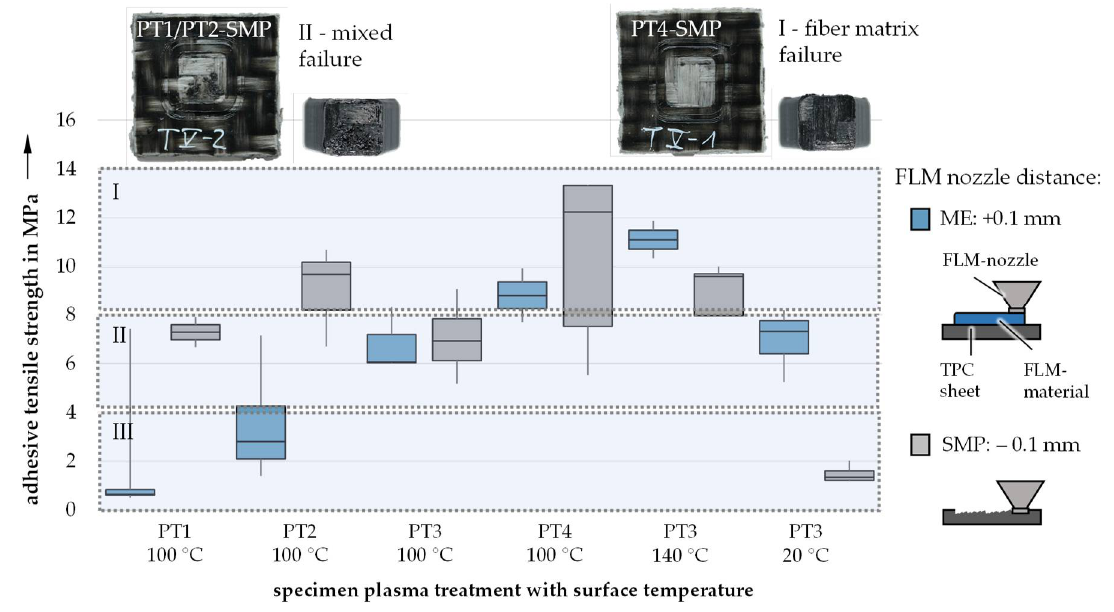
Figure 7. Influence of plasma treatment on bonding strengths.